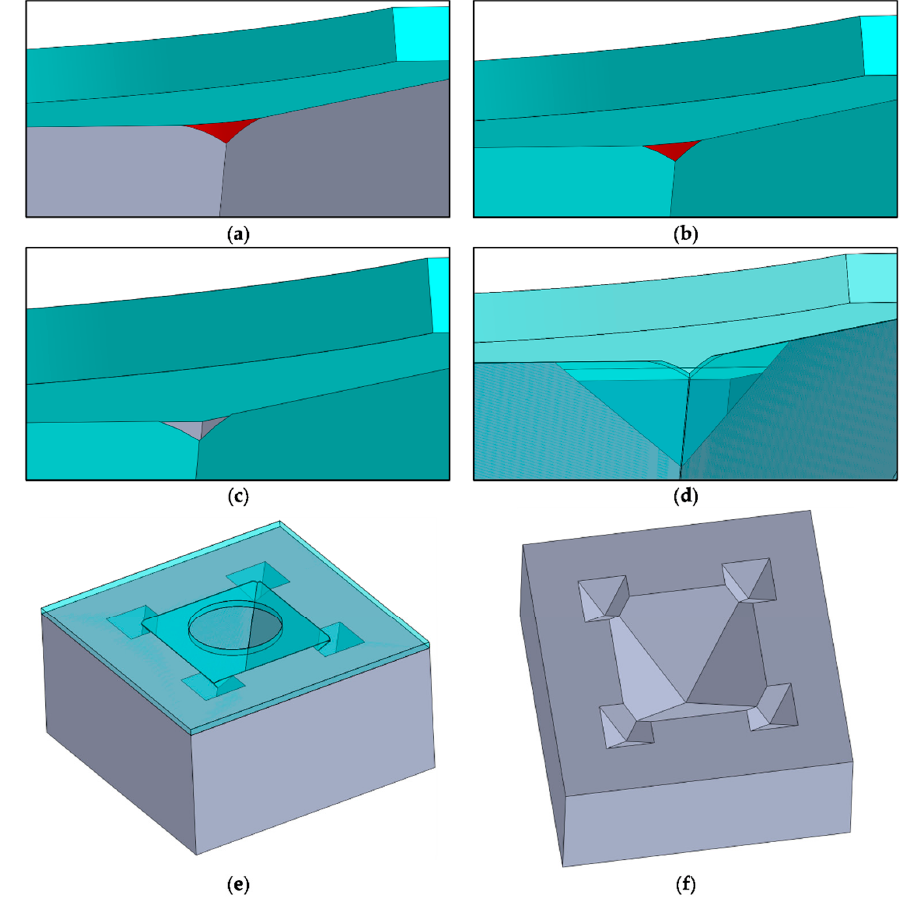
Figure 9. Second part of the process flow demonstrating how to create the G2 fractal: ( a ) Enlarged vertex of the base of the pyramid with Si 3 N 4 nanodot (red). ( b ) Vertex with nanodot after LOCOS of the Si (grey). ( c ) Vertex after etching of the nanodot. ( d ) Vertex after etching the Si, creating the G2 fractal. ( e ) Top-view of the G1 and G2 fractal under the SiO 2 (blue) mask. ( f ) Top-view of the G1 and G2 fractal in Si without the planar hard-mask.